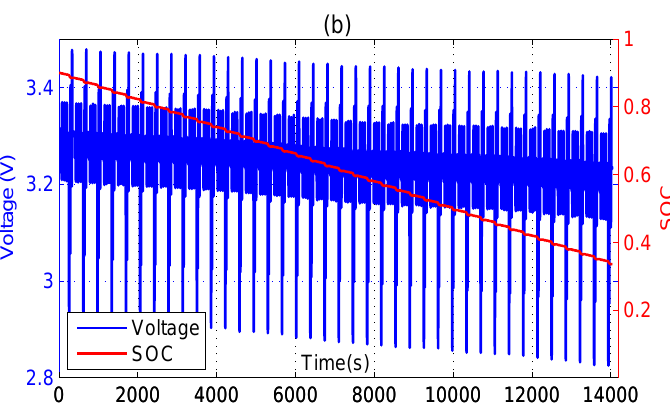
Figure 5. ( a ) Dataset of dynamic stress test (DST) on WB-LYP40AHA: current; ( b ) Dataset of DST on WB-LYP40AHA: voltage and SOC.